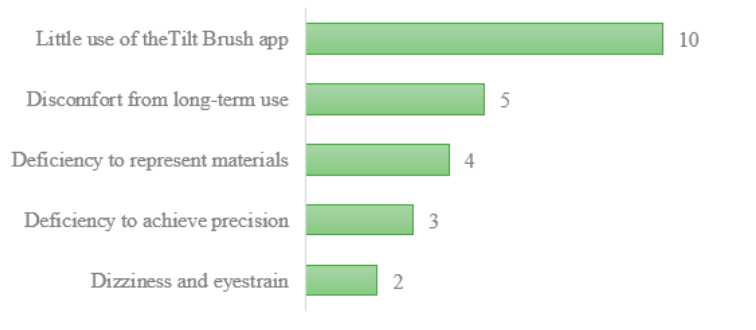
Figure 7. The most highly rated advantages of using IVR in design, according to students.